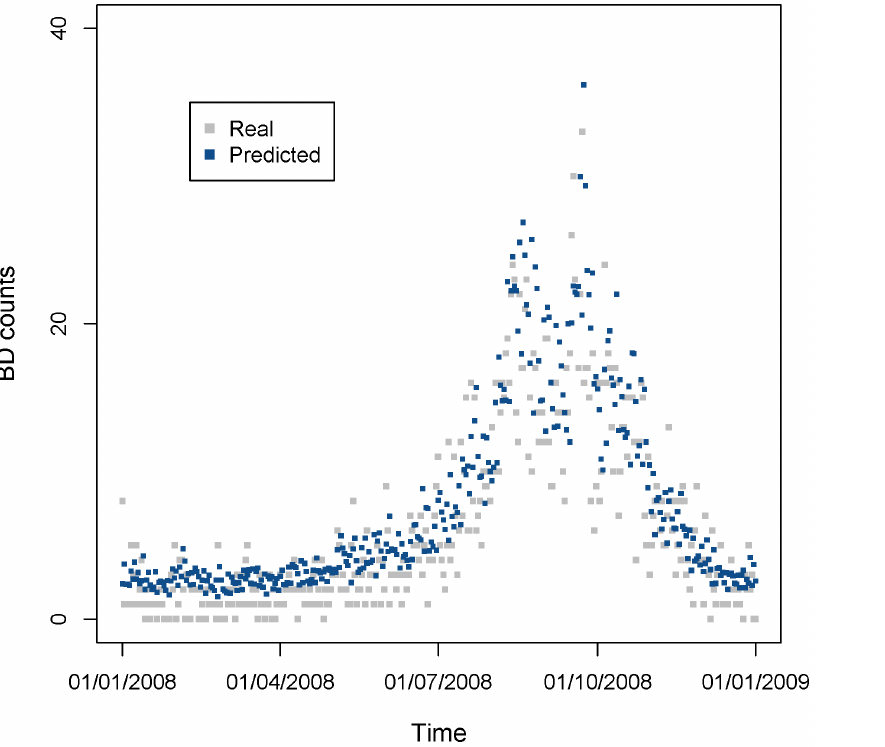
Figure 11. Real and predicted BD counts using the estimated expression of predictive MGAM model in 2008. The light gray points are real daily BD counts in 2007, and the dark blue points are predicted BD counts using predictive MGAM model. Correlation coefficient between the real and predicted value is 0.859.